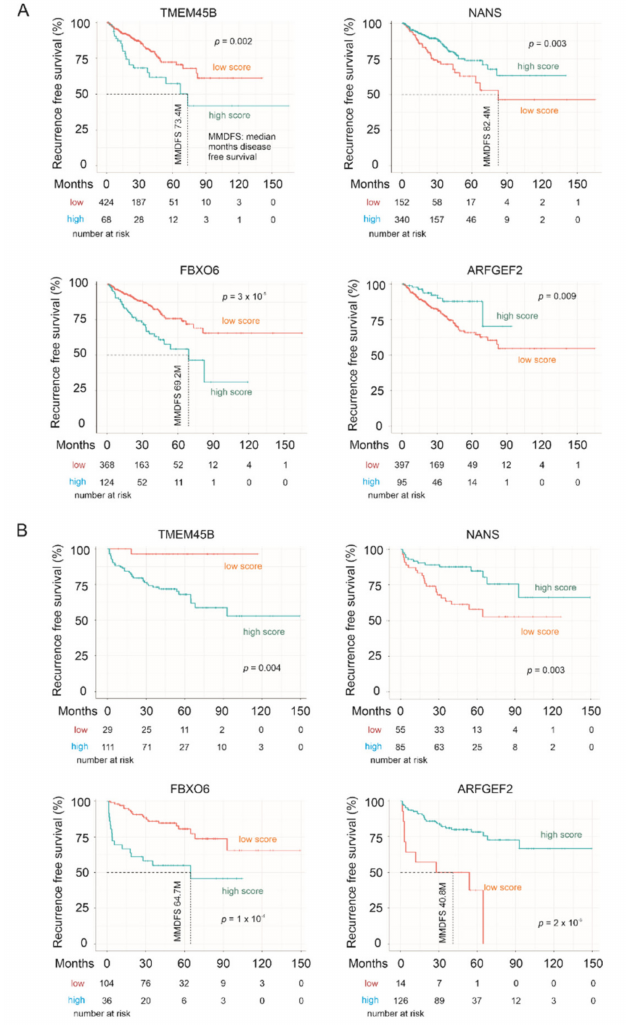
Figure 8. LE gene expressions stratify the risk of prostate cancer recurrence. The Kaplan–Meier survival curves for the indicated genes were produced with the R survival package using data from the TCGA PanCancer ( A ) and MSKCC ( B ) cohorts. Cutoff points for individual genes were obtained using the R Maxstat package. Statistical analyses were performed using logrank